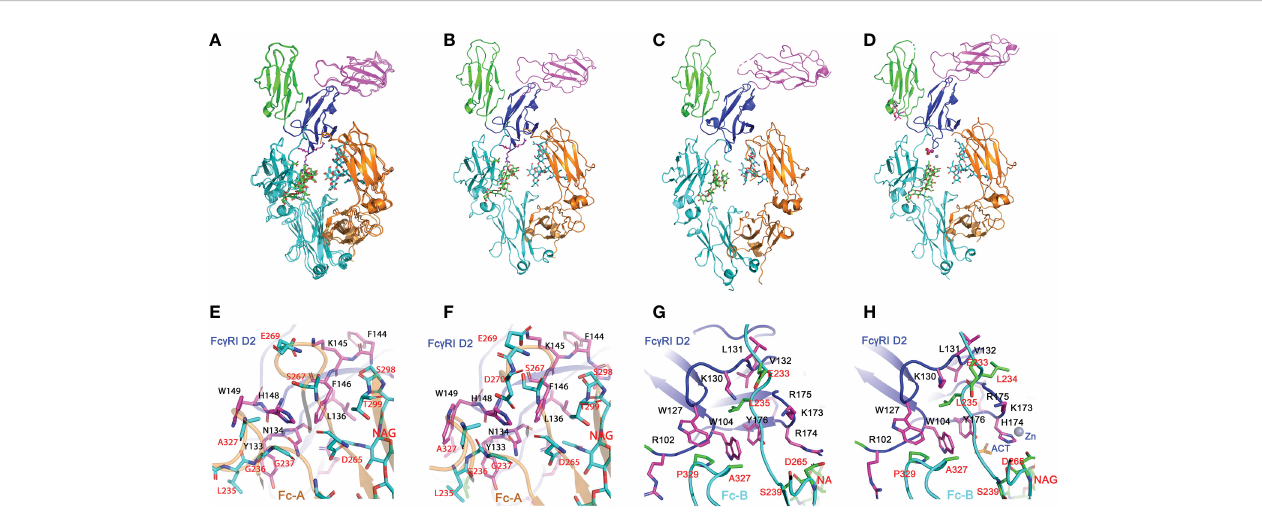
FIGURE 2 Structures of H174R Fc g RI in complex with IgG 1 Fc. (A) Structure superposition of three structures of Fc g RI H174R variant in complex with Fc (PDB code: 8DIR, 8DIN and 8DJ7). All structural alignments were based on D2 domain of Fc g RI. D1, D2 and D3 domain of Fc g RI were highlighted as cartoons in green, blue, and magenta, respectively. The Fc chain (A, B) were colored in orange and cyan, respectively, with glycosylation attached to Asn 297 shown in stick model. (B, D) Structures of individual Fc g RI-Fc complexes, 8DIR (B) , 4X4M (C) and 4W4O (D) . The acetate and Zn atom bound to H174 are shown in spheres. E-F) Interface contact region between Fc g RI D2 domain and Fc-A chain as observed in 8DIR (E) and 4W4O (F) . (G, H) Interface between H174R Fc g RI D2 domain and Fc-B chains observed in 8DIR (G) and 4W4O (H) . Fc g RI residues were shown as magenta sticks and labelled in black. Residues from Fc chains were shown as cyan or green sticks and labelled in